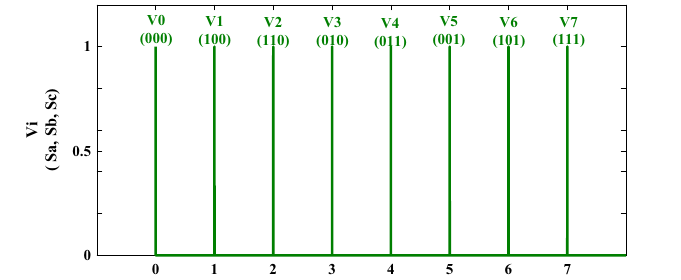
Figure 6. The membership functions for the